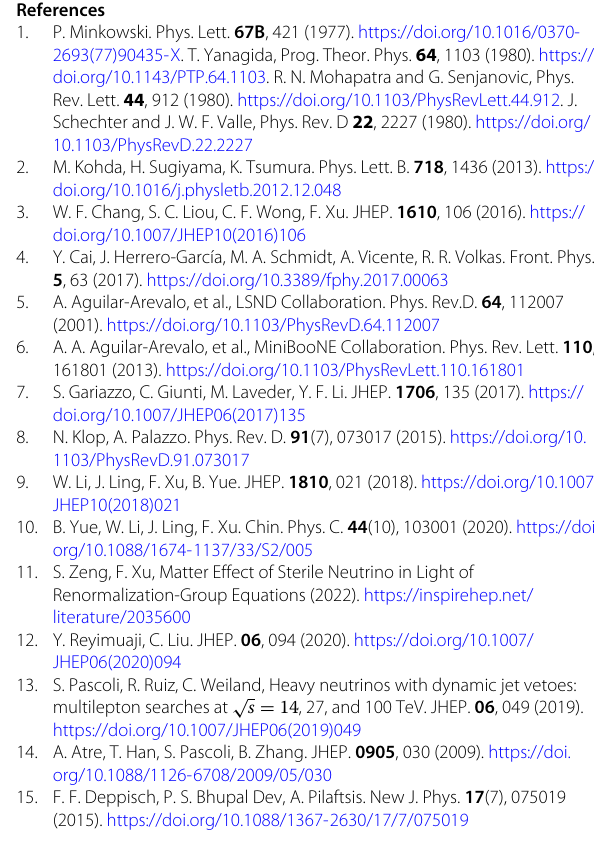
from different parent particle, we find the allowed range of parameter space of sterile neutrino is mass dependent.